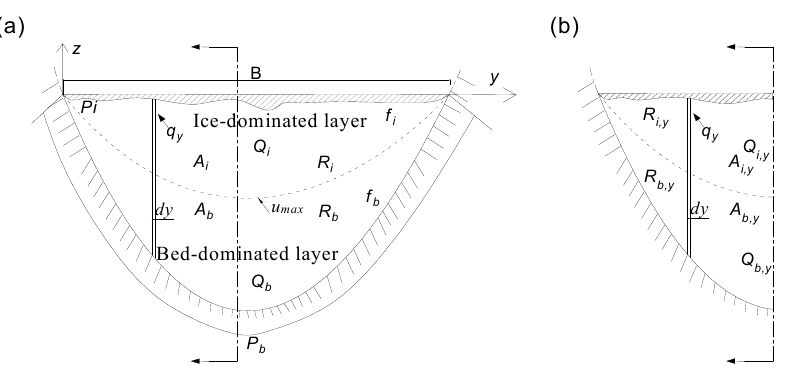
Figure 1. Flow profile is divided into bed- and ice-dominated layers: ( a ) entire cross-section; ( b ) partial cross-section.